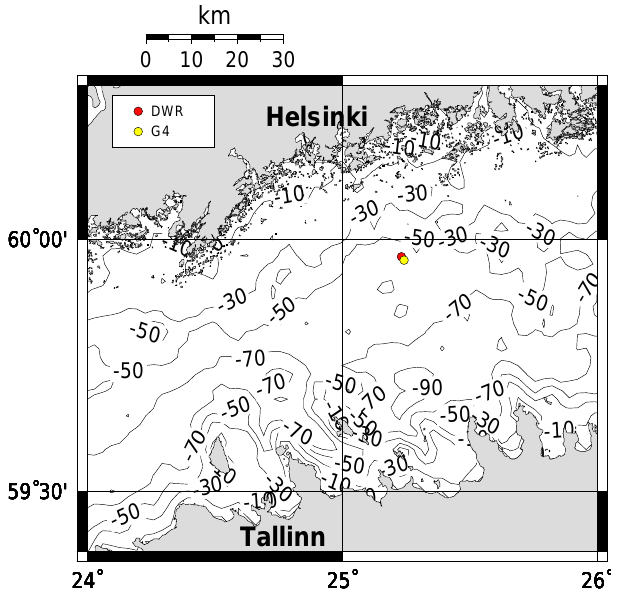
Figure 4. The location of the deployed wave buoys in the Gulf of Finland. The operational DWR (red circle) is anchored at a depth of 62m at 59 ◦ 57.90 (cid:48) N, 025 ◦ 14.11 (cid:48) E. The G4 (yellow circle) was anchored at a similar depth at 59 ◦ 57.50 (cid:48) N, 025 ◦ 14.57 (cid:48) E.